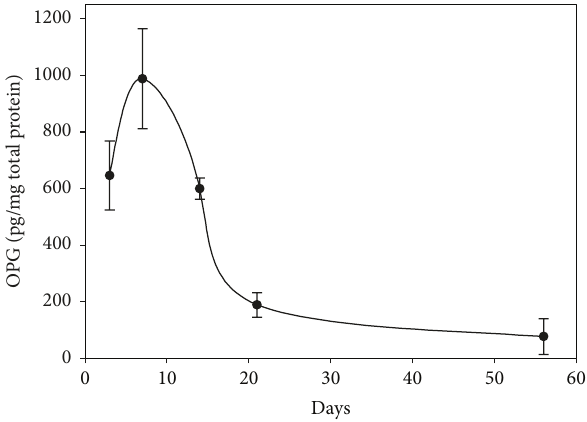
Figure 1: ELISA was performed to determine the transgene expres- sion. hOPG protein was sustained expressed for at least 21 days, with the peak at 7 days following gene